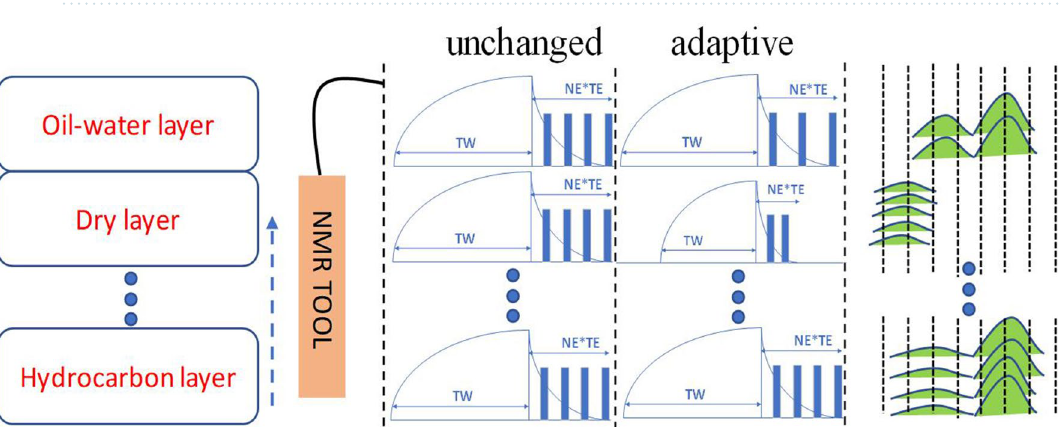
Figure 1. Original echo trains and T 2 spectra of the same sample with different pulse sequence parameters, assuming that TW is sufficiently large. ( a ) Echo trains data points acquired with different parameters. ( b ) T 2 spectra obtained by the inversion of echo trains with different acquisition parameters.